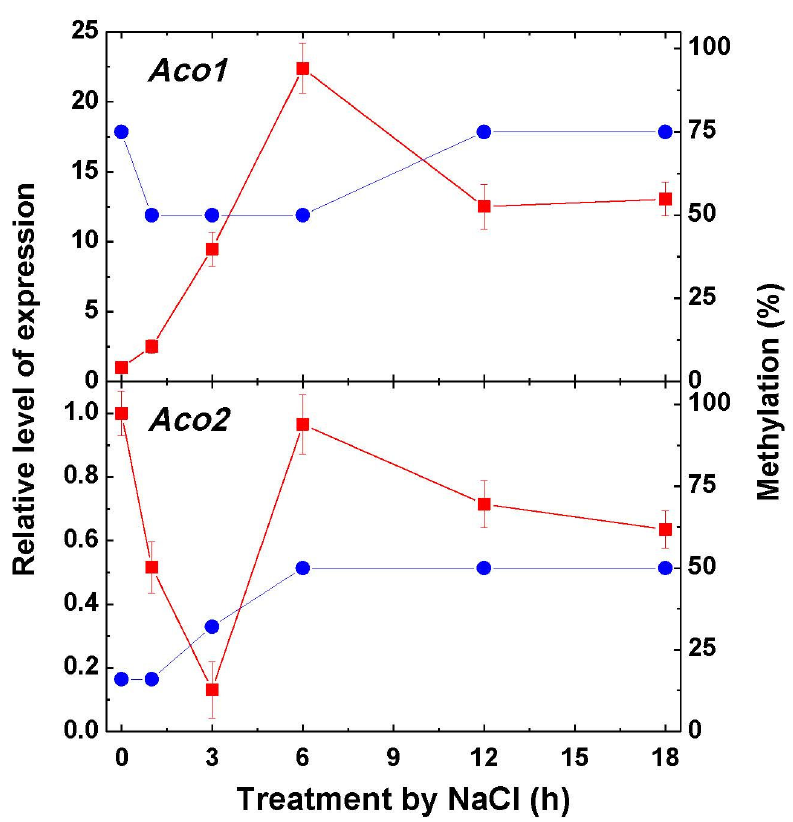
Figure 3. Relative level of transcripts of the genes Aco1 and Aco2 and the rate of methylation of their promoters in maize leaves in the course of incubation of maize seedlings in 150-mM NaCl. The data represent the means of three biological repeats ± SD. The control (untreated) samples of gene expression values did not exhibit statistically significant changes in the variation level.